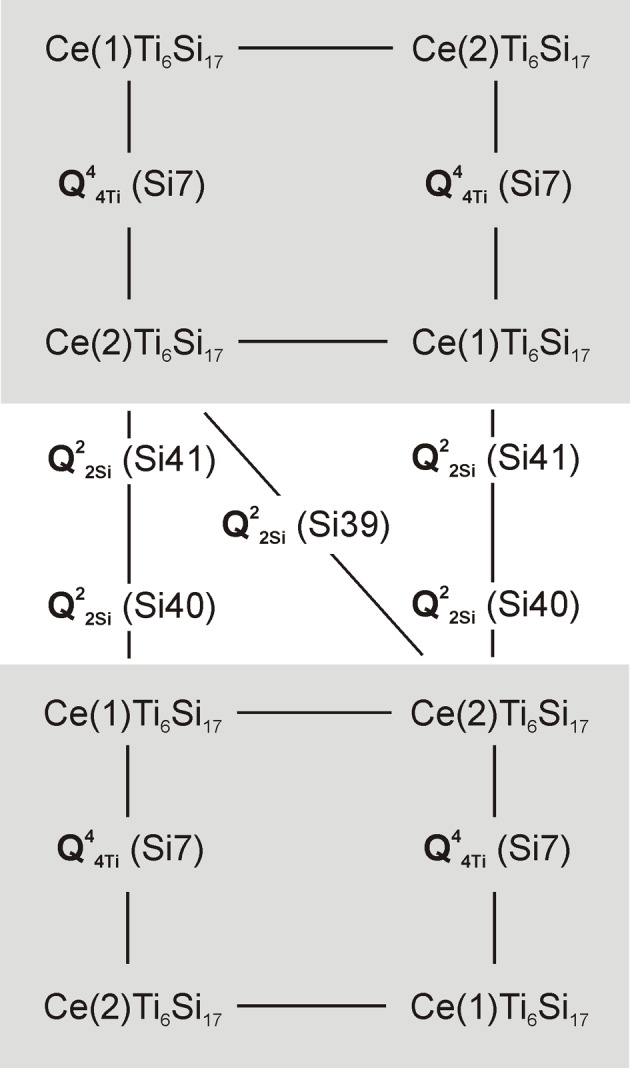
Schematic representation of the topology of ribbons formed by TPTS (CeTi6Si17) clusters in ilmajokite (four-membered rings are highlighted in gray).